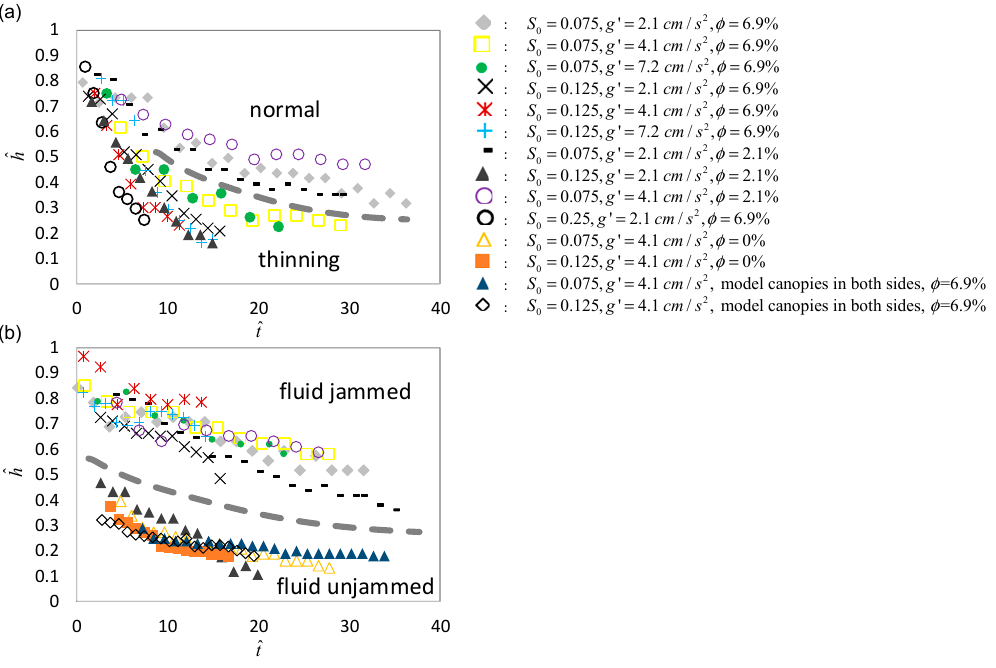
Figure 9. Normalized temporal variation in current thickness at the lock of the tank: ( a ) a model canopy distributed in shallows; and ( b ) a model canopy distributed in deep regions.